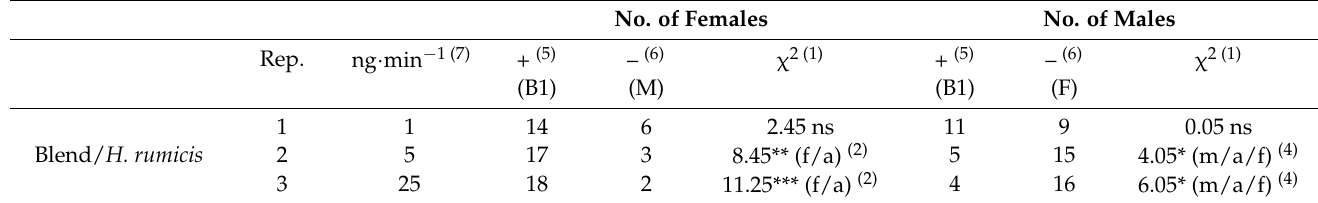
Table 4. Effects of rates of dose (ng · min − 1 ) for synthetic blend 1 (B1), consisting of five GLVs [( Z )- 3-HAL + ( E )-2-HAL + ( Z )-3-HOL + ( E )-2-HOL + ( Z )-3-HAC] (three tested doses—only attractants identified in Table 2) on the number of mated H. rumicis adult females and males choosing to enter a Y-tube arm containing the volatile blend or the Y-tube arm containing only female or male individuals. No. of Females No. of Males